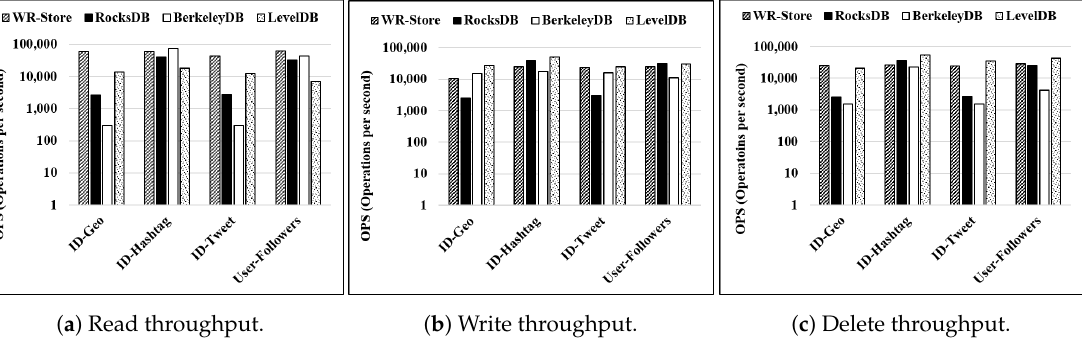
Figure 12. Throughput on various real data sets. ( a ) Read throughput; ( b ) Write throughput; ( c ) Delete throughput.